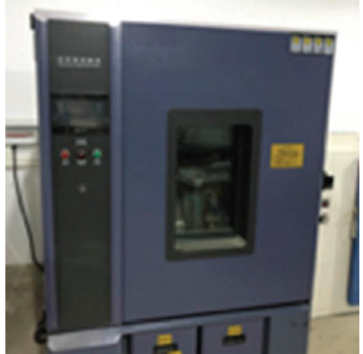
Figure 6: Insulating in the temperature test chamber.